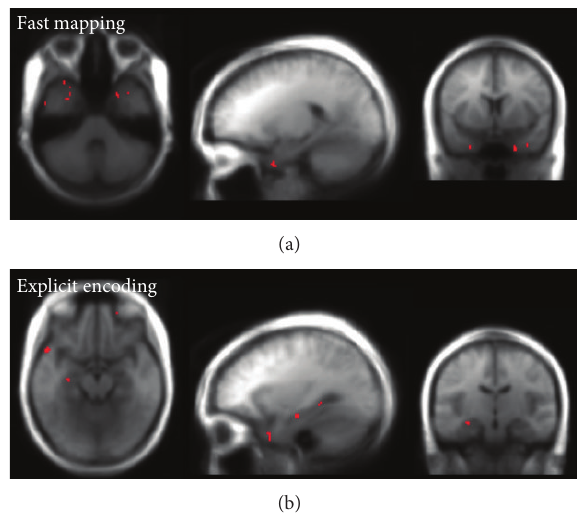
Figure 3: Importance maps resulting from the feature selection procedure of fast mapping (a) and explicit encoding (b).